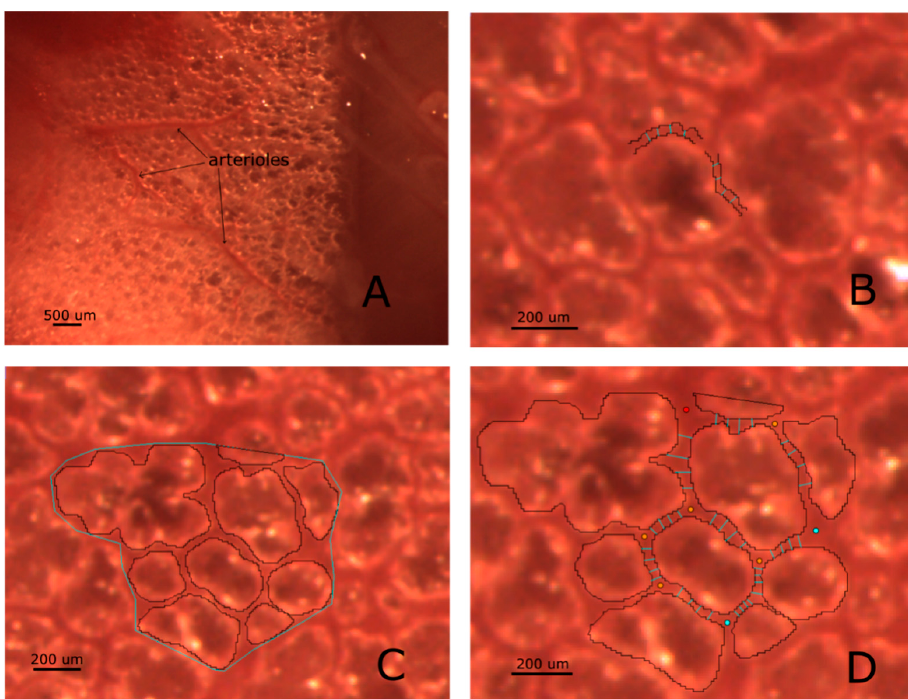
Figure 2. Panel ( A ) is representative of a subpleural region imaged through the intact pleura: alveoli as well as surface microvessels are clearly visible. Panel ( B ) illustrates the result of the method used to derive the diameter of a vessel (we name this technique “segmentation”), based on the definition of microvessels borders described in Methods; vessel diameters are estimated by averaging four adjacent diameters. The same approach is used for both distribution and corner vessels. In Panel ( C ), an estimate of interstitial space is given by the difference between the area encompassing the Region of Interest (ROI) and the overall sum of alveolar surfaces. Panel ( D ) clarifies how a 2D morphological model can be obtained from subpleural images: arteriolar inputs and venular outputs access points are defined (red and cyan points, respectively); corner vessel diameter is estimated by averaging four adjacent diameters.